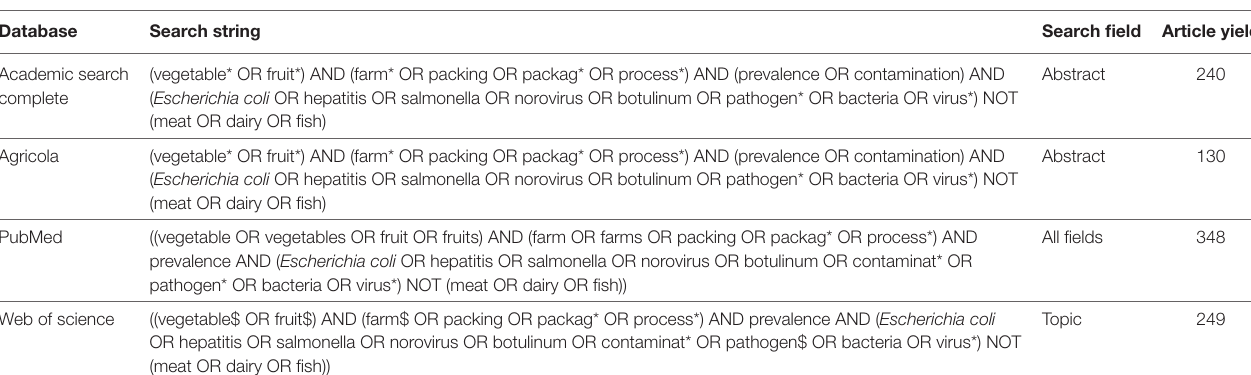
tabLe 1 | Overview of search string